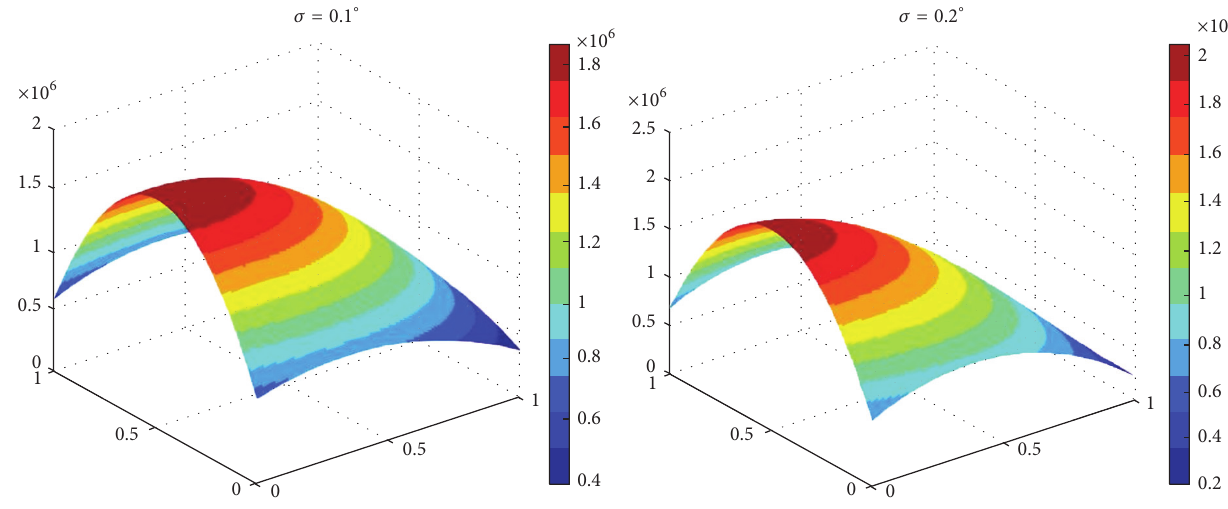
Figure 6: Flux distribution at deflection angles of 0.1 ∘ and 0.2 ∘ .